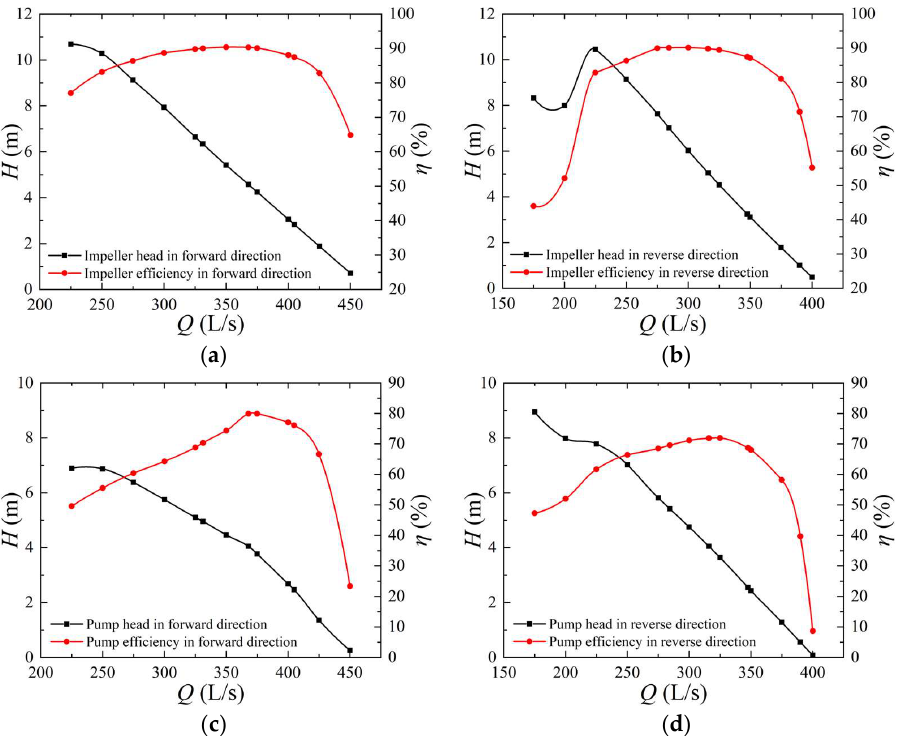
Figure 7. Numerical calculation curve of energy characteristics: ( a ) Forward bidirectional pump impeller; ( b ) Reverse bidirectional pump impeller; ( c ) Forward bidirectional pump; ( d ) Reverse bidirectional pump.